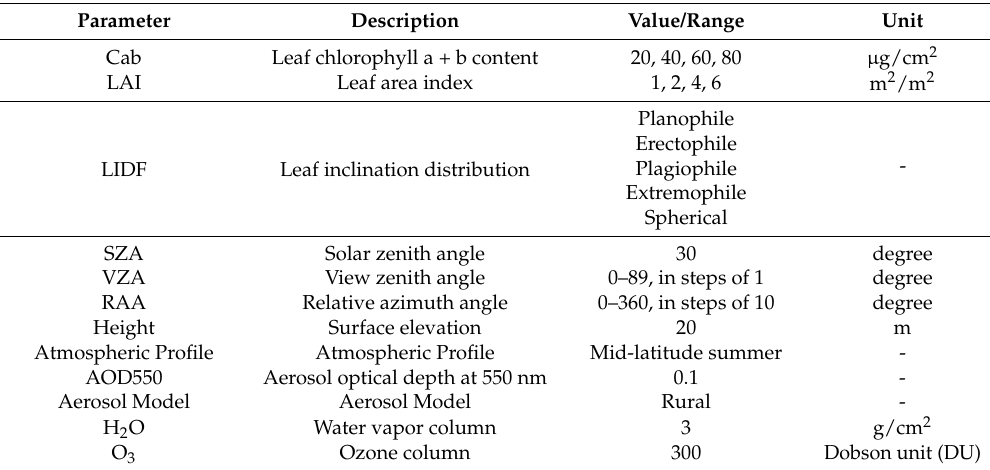
Table 1. Main parameters for simulation in SCOPE and MODTRAN 5